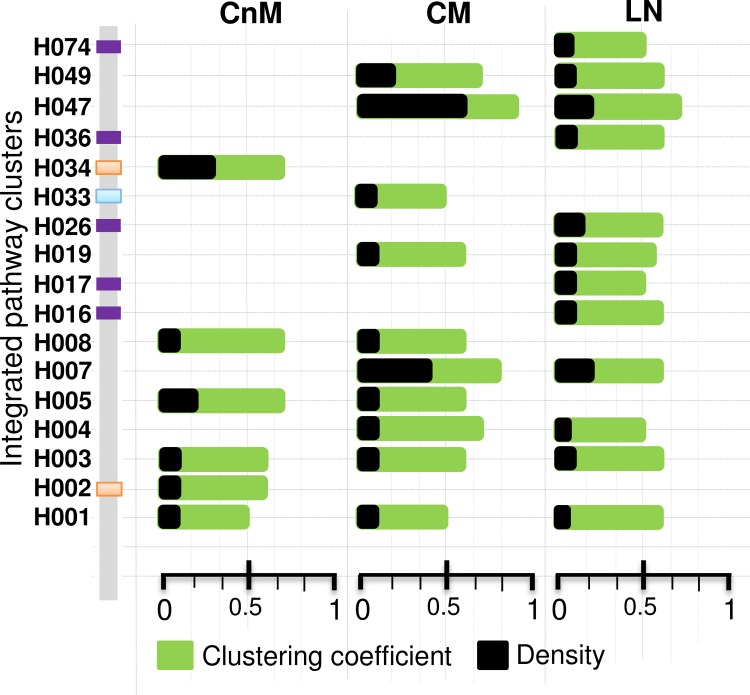
Predicted IPCs identified in each melanoma stage along with the two fundamental network properties (clustering coefficient and density) of its enriched genes.The colored strip represents stage specific IPCs; orange is CnM specific, grenn is CM specific and voilet is LN specific. More information about the IPCs is available in S3 File.